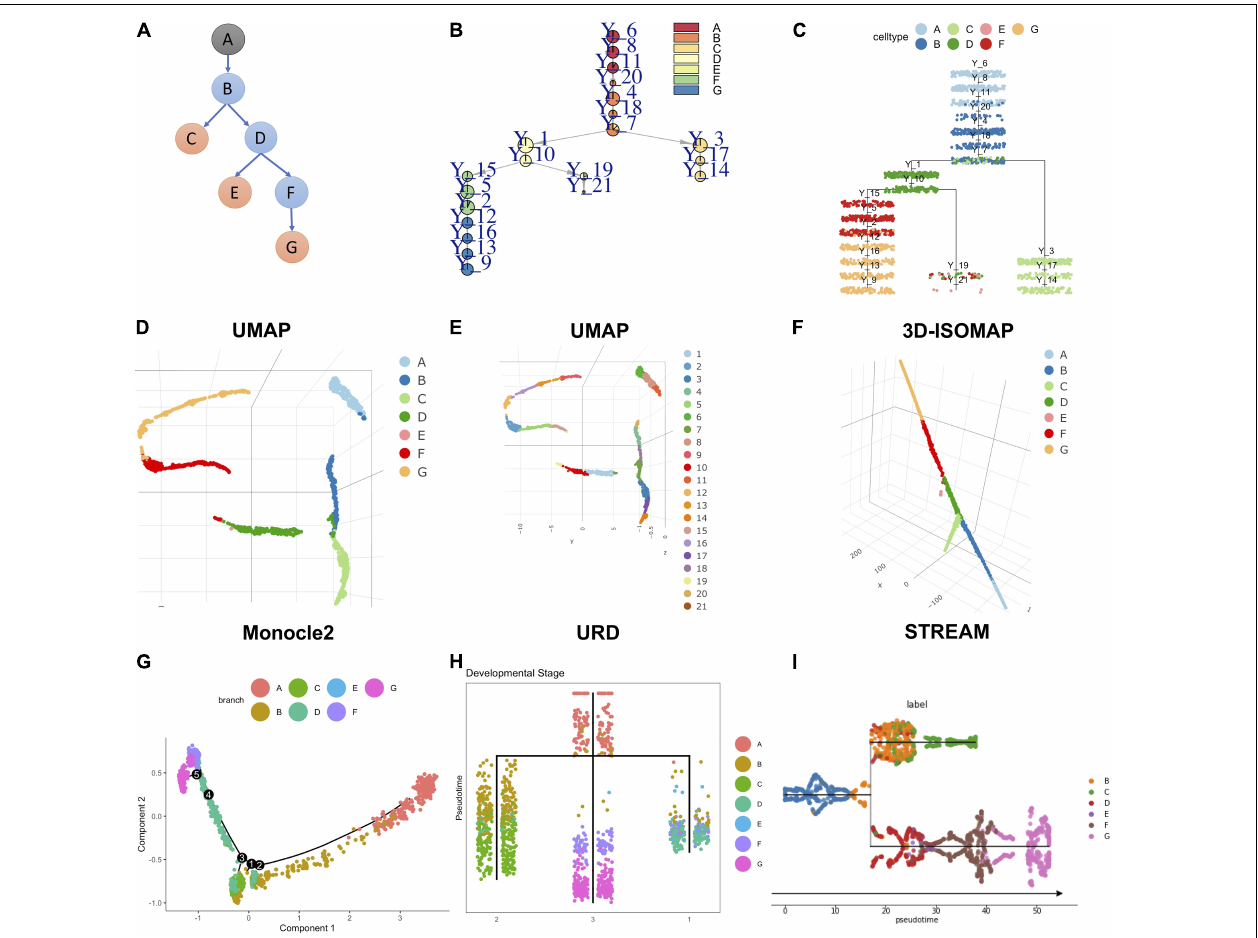
FIGURE 4 | Rare cell branch detection using LISA2 on simulated data. (A) The cartoon plot of the trajectory of simulated data with rare cell type E (15 cells, 0.78%). The gray A node is the root. The orange nodes are the leaf branches. The blue nodes are the middle branches. (B) Pie tree plot shows the cell types and trajectory. (C) Cell cluster tree plot shows the differentiation trajectory. (D) The cell type visualization in UMAP. (E) The clustering results in UMAP. (F) Cell type visualization in 3D L-ISOMAP. (G) Monocle 2 trajectory for the simulated data (top 10 PCs used). (H) The URD trajectory for the simulated data. (I) The STREAM trajectory for the simulated data (all genes were